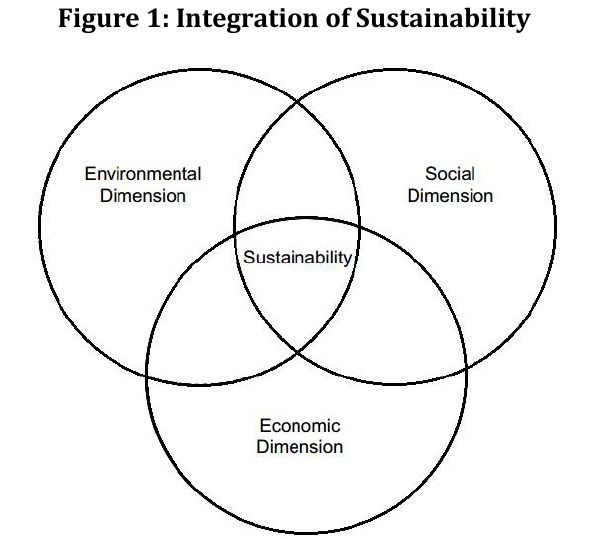
Source : Adapted from Winter & Knemeyer, 2013, p. 23